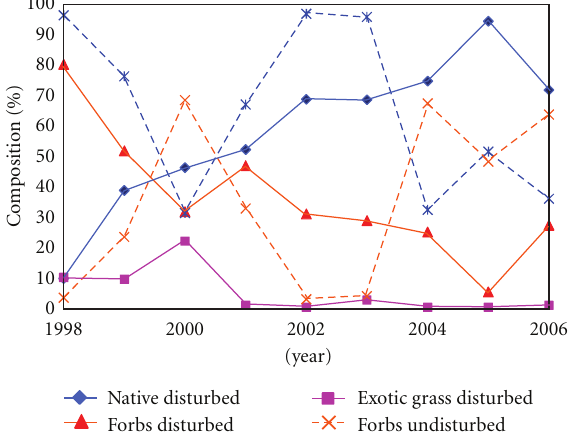
Figure 4: Herbaceous species compositionat the disturbed (distbd) and undisturbed (undistbd) sites in CKGR: 1998 to 2006.